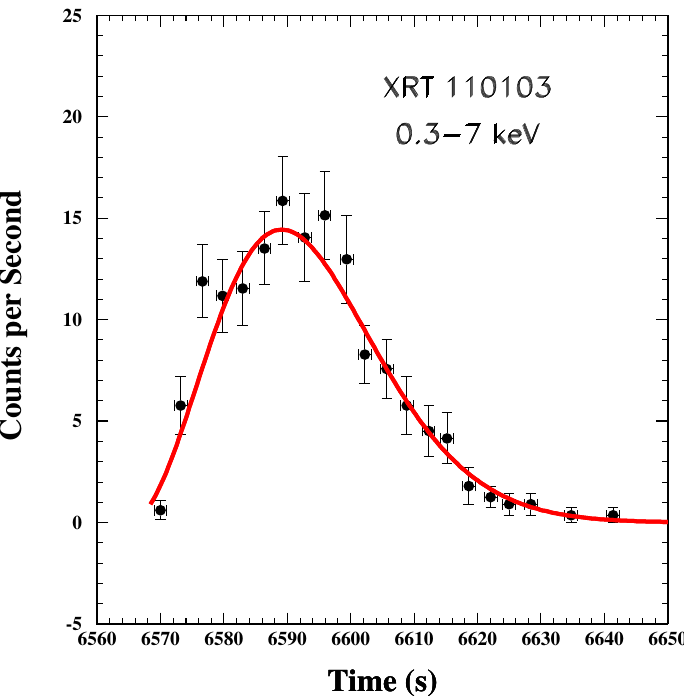
Figure 30. The pulse shape of XRT 110103 [181] and the CB-model shape of Equation (24) with the best fit parameters, ∆ = 45.03 s, τ = 23.16 s, E p ( 0 )= 12.18 keV (for time t since 6564.90 s); χ 2 /dof =